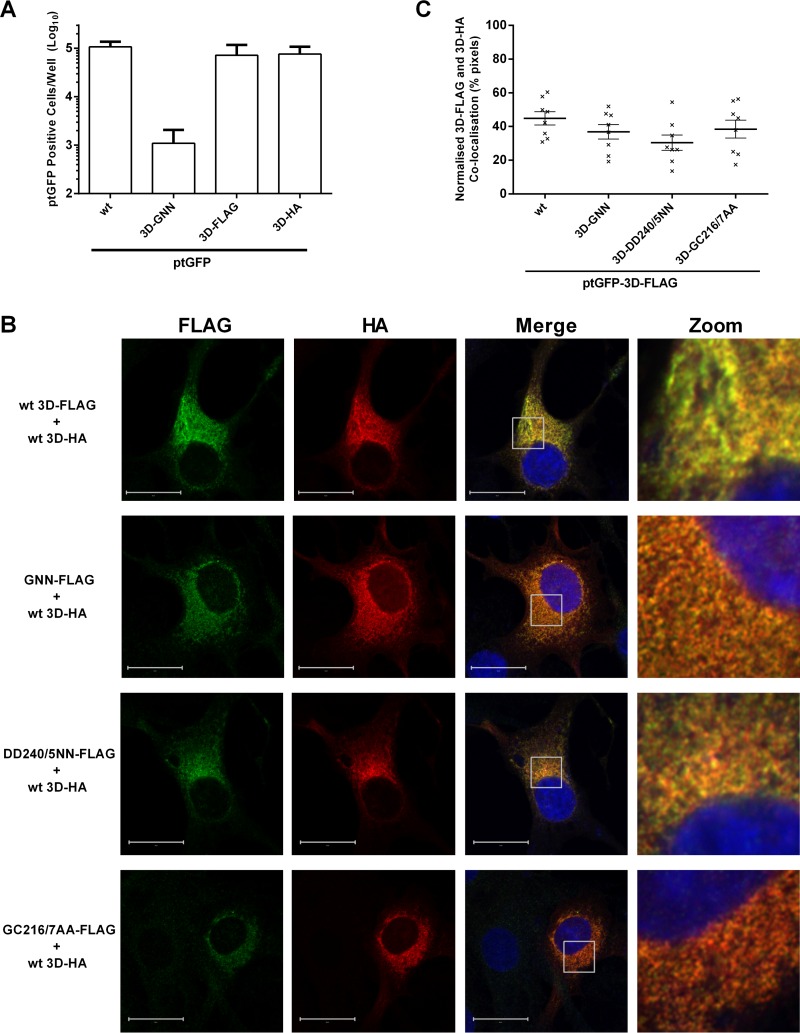
Wild-type helper 3D colocalizes with replication-defective mutant 3D. (A) Replicon RNAs containing C-terminal epitope labels were transfected into BHK-21 cells, and ptGFP expression was monitored hourly over a 24-h period. Data show mean numbers ± SD of ptGFP-positive cells per well at 8 h posttransfection (n = 2). (B) BHK-21 cells were cotransfected with FLAG-tagged mutant 3D replicons and HA-tagged 3D helper replicons, fixed at 4 h posttransfection, and labeled for FLAG-Alexa Fluor 568 (pseudocolored green) and HA-Alexa Fluor 647 (pseudocolored red) as described in Materials and Methods. Cell nuclei were counterstained with DAPI (blue). Images were captured on a Zeiss LSM-880 confocal microscope with Airyscan. Zoomed images represent the boxed areas on the merged images (bar, 20 μM). (C) Quantification of FLAG versus HA colocalization by confocal immunofluorescence. Fluorescent intensity of 3D-FLAG (green) versus 3D-HA (red) was plotted as two-dimensional (2D) scatterplots, and the number of costained pixels was determined by a 4-area gating set using controls. Data points show the percentages of coexpressing pixels from 8 randomly selected cells after cotransfection. Horizontal lines represents mean values ± SEM.